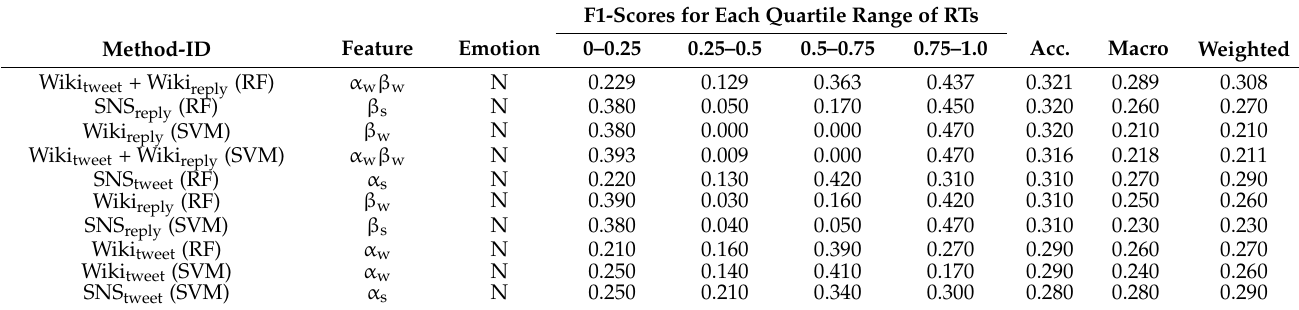
Table 7. Top 10 F1-scores and accuracies of RT prediction (baseline methods). F1-Scores for Each Quartile Range of